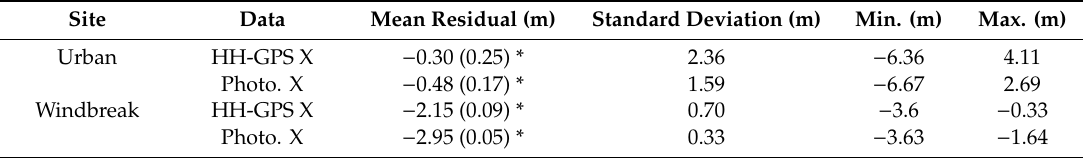
Table 4. A comparison of X-coordinate di ff erences for tree positions between satellite interpreted coordinates from field-based GPS and